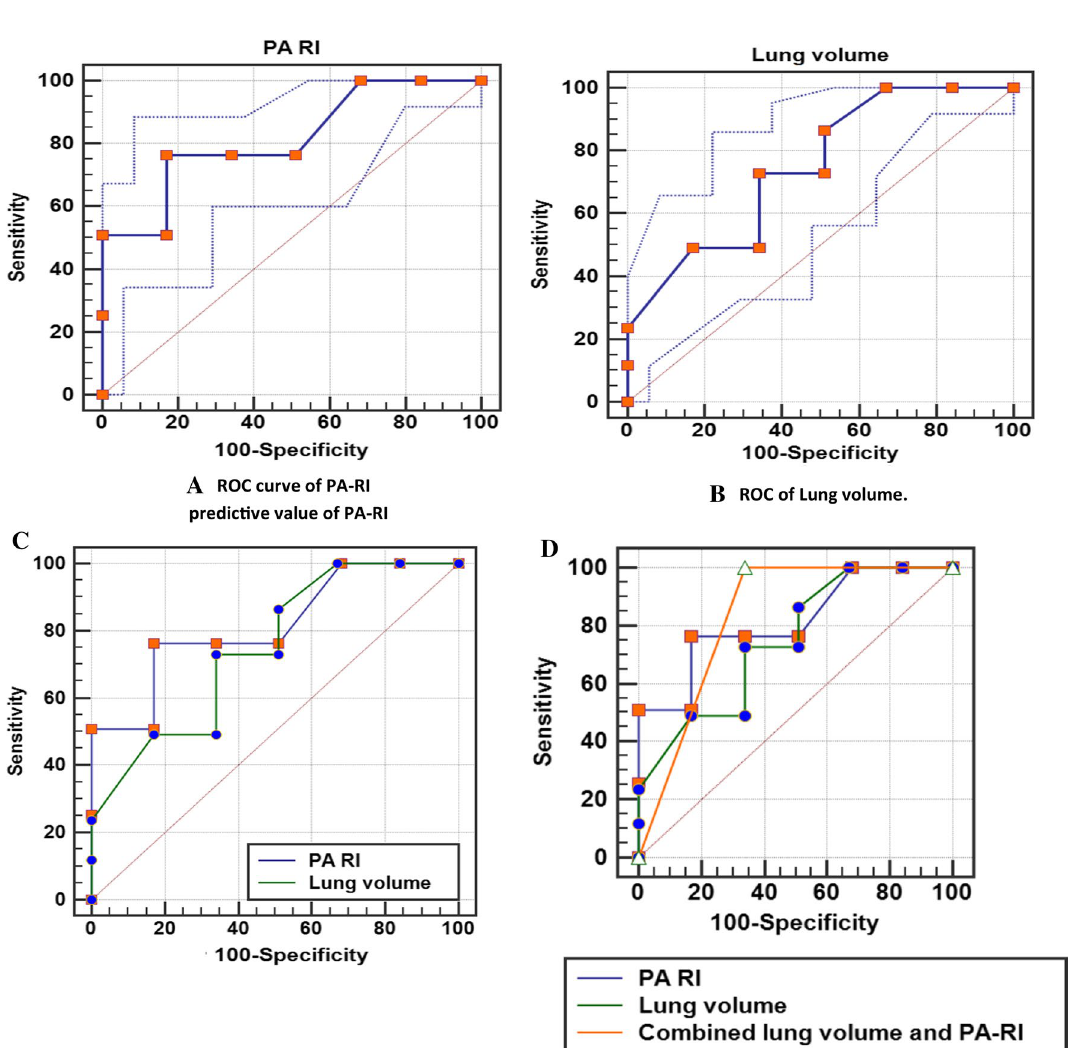
Fig. 4 Receiver operating curve (ROC) of the A PA‑RI, B LV, C PA‑RI and LV and D Combined PA‑RI and LV for showing cutoff value predicting neonatal respiratory distress syndrome